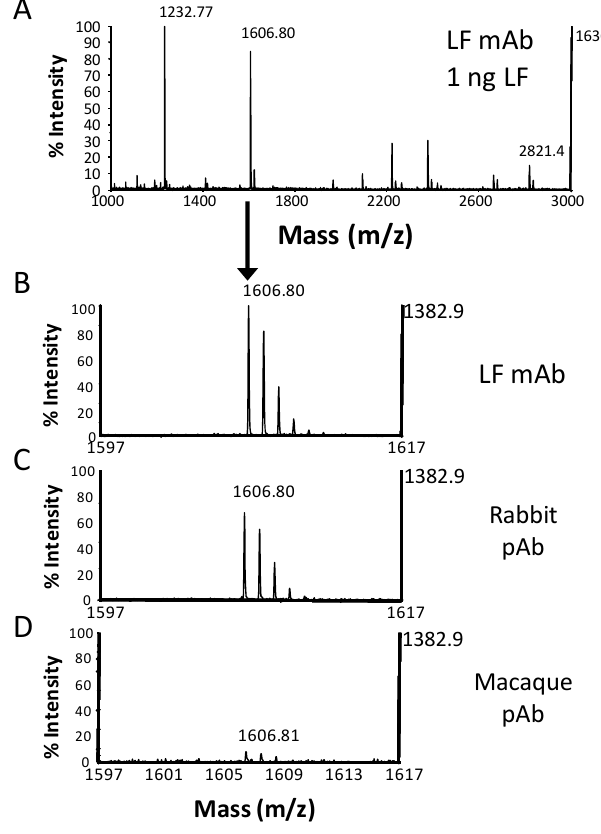
Figure 7. Mouse mAb’s, polyclonal serum (pAb) from rabbit immunized with LF, and pAb from rhesus macaque immunized with LF were covalently linked to protein